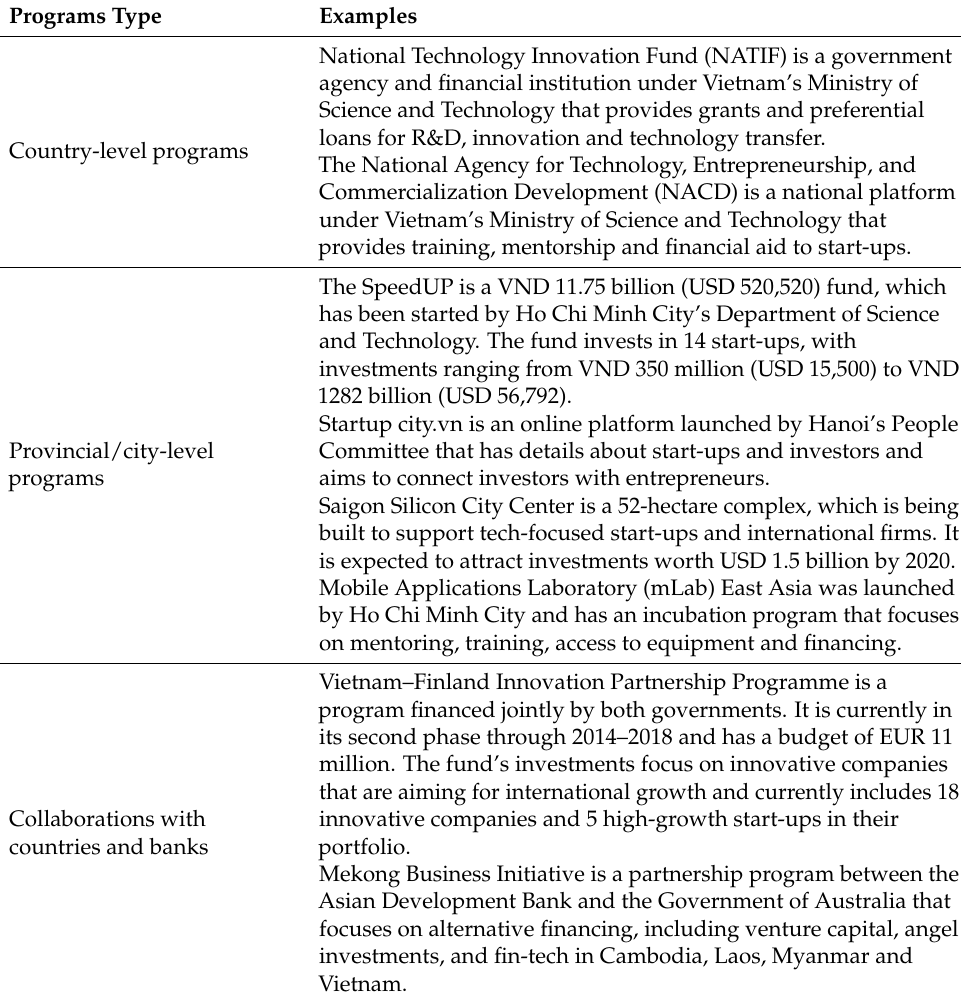
Table 1. Examples of governments’ start-up